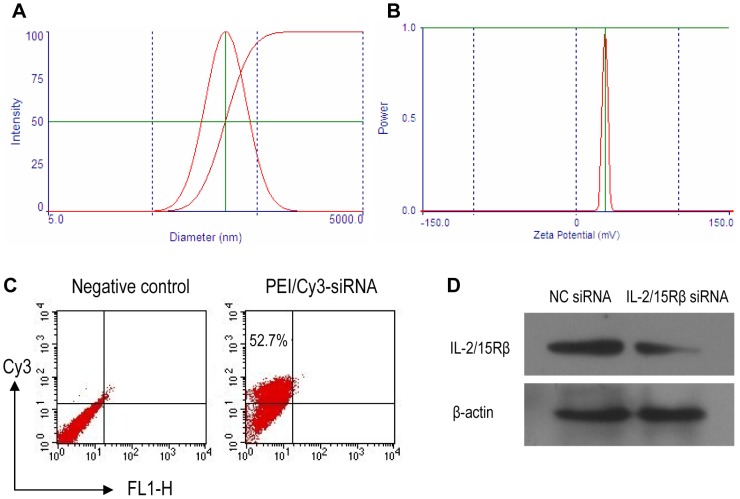
Physical and biological characterization of PEI/siRNA complexes.siRNA was complexed with in vivo-jetPEI at N∶P ratio of 6. (A) Hydrodynamic size distribution, and (B) zeta potential of PEI/NC siRNA complexes analyzed by DLS. (C) Flow cytometric analysis of the uptake of siRNA polyplexes in rat peritoneal macrophages. Cells were incubated with PEI-formulated Cy3-siRNA (40 nM) for 12 h. As negative control, cells were incubated with PEI/NC siRNA. (D) Western blot analysis of IL-2/15Rβ silencing in rat peritoneal macrophages. Macrophages were transfected with PEI/IL-2/15Rβ siRNA complexes for 48 h.